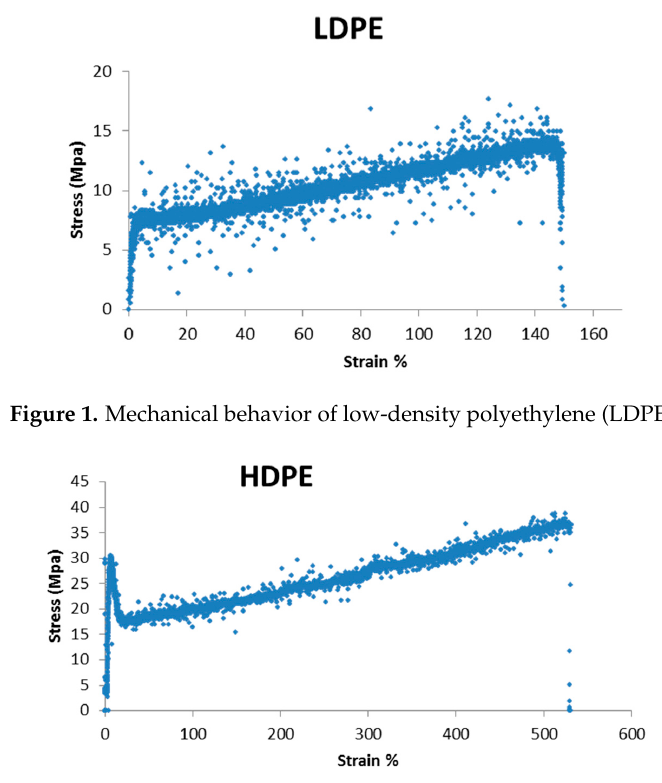
Figure 2. Mechanical behavior of high-density polyethylene (HDPE).